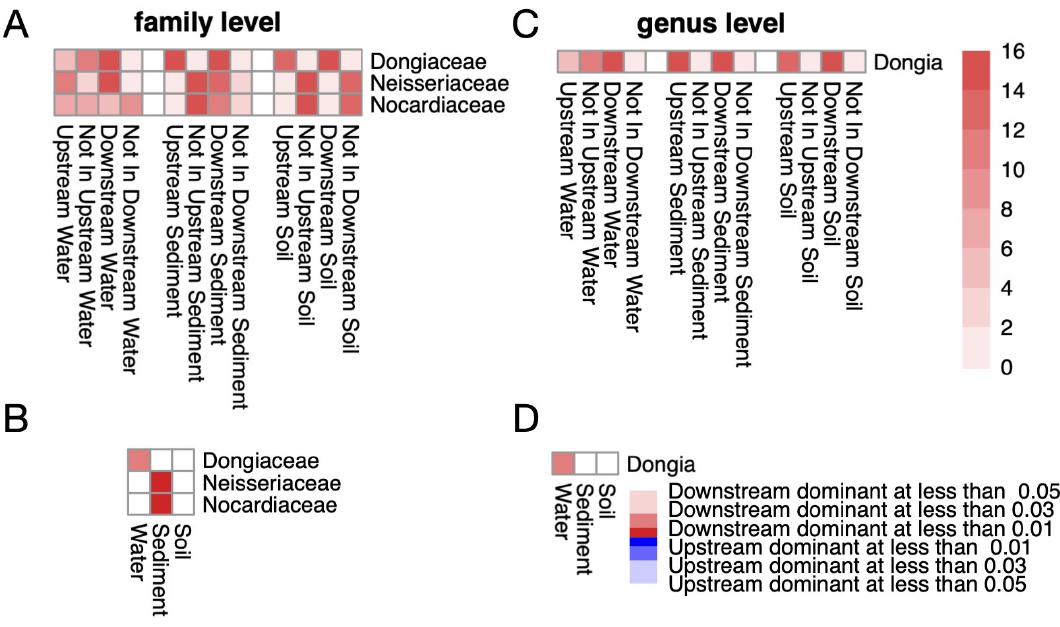
Figure 7. Taxa at the family ( A , B ) and genus ( C , D ) level that are significantly different in their pattern of exclusion across samples. For each taxa, the number of samples for which the taxa were present ( A , B ) were evaluated for pairs of habitats with the Fisher test (see Figure S4) and taxa were considered significantly different at a 5% FDR threshold with p values adjusted by Benjamini-Hochberg correction ( C , D ).